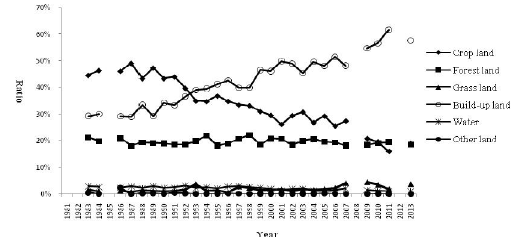
Figure.1 Index system for national condition monitoring